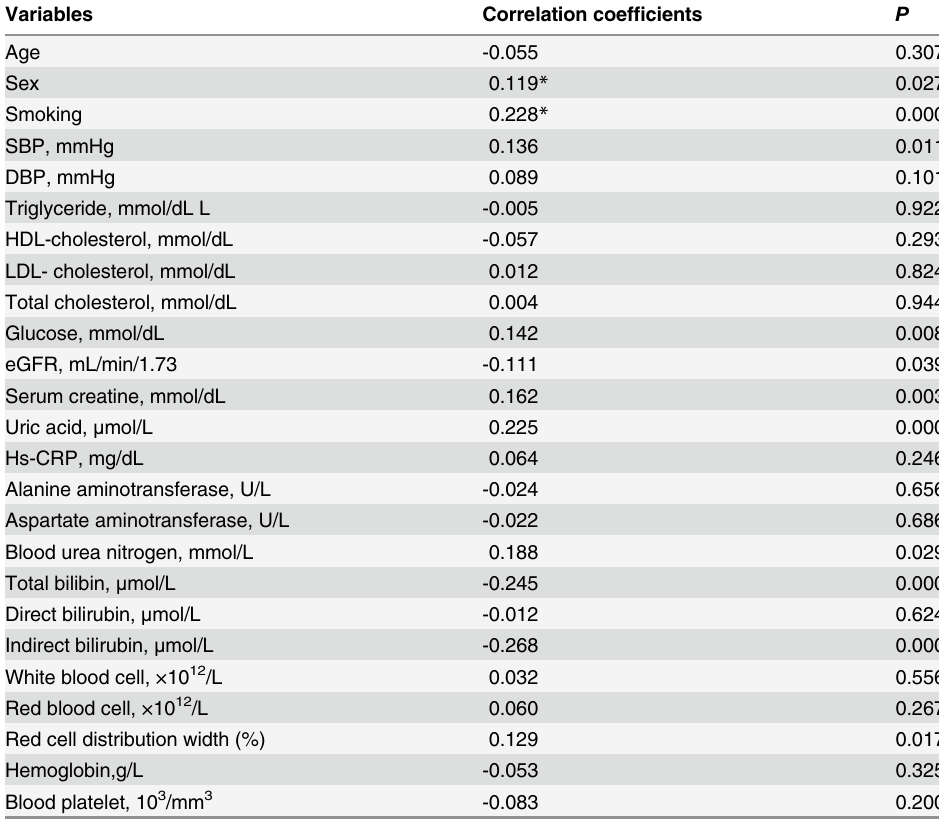
Table 2. Correlation coefficients of relation between left ventricular mass index and some parameters.